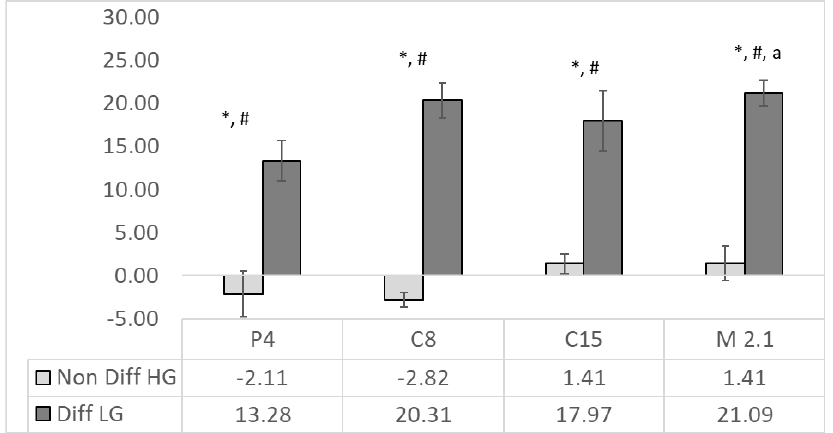
Figure 2. ALP activity (%) in supernatants from C15, M2.1, P4 C8 strains of Lacticaseibacillus paracasei in non-differentiated (in light grey) and differentiated (in dark grey) human colorectal adenocarci- noma HT29 cells. The ALP activity is calculated as a % of the MRS ( n = 4, ±SEM, significance: to the relative MRS control LG/HG for non-differentiated and differentiated cells, respectively — p < 0.001 = *; non-differentiated vs. differentiated p < 0.001 = #; and differentiated P4 to M2.1 to p < 0.05 = a.